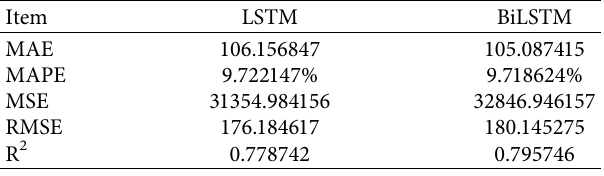
Figure 9: Comparison on prediction results of BiLSTM and Table 2: Indicators for prediction performance of BiLSTM.